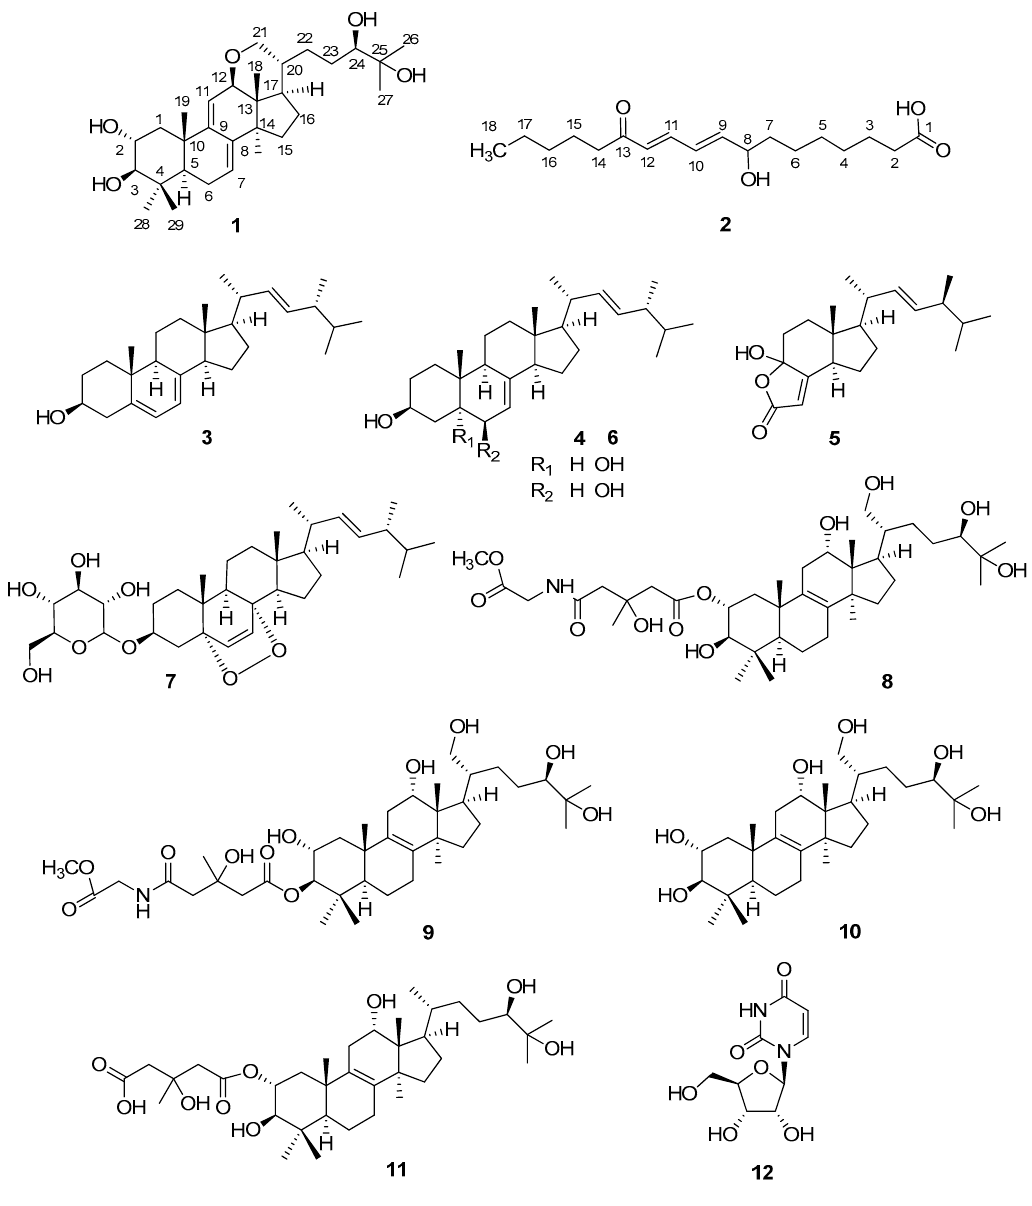
Figure 1. Structures of compounds isolated from H. lateritium.